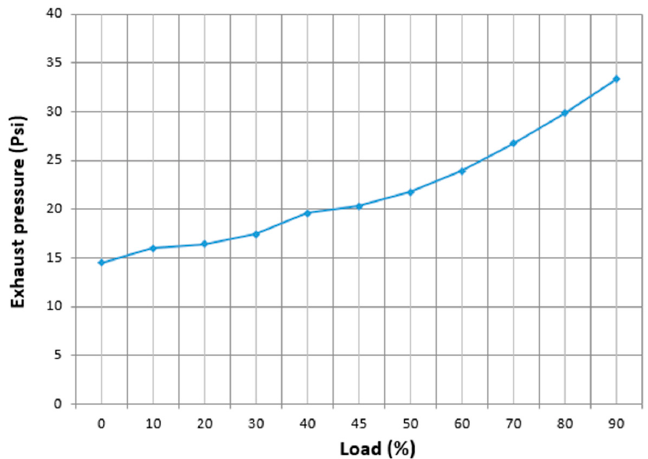
Figure 2. Relationship between %load and exhaust pressure of ICE.